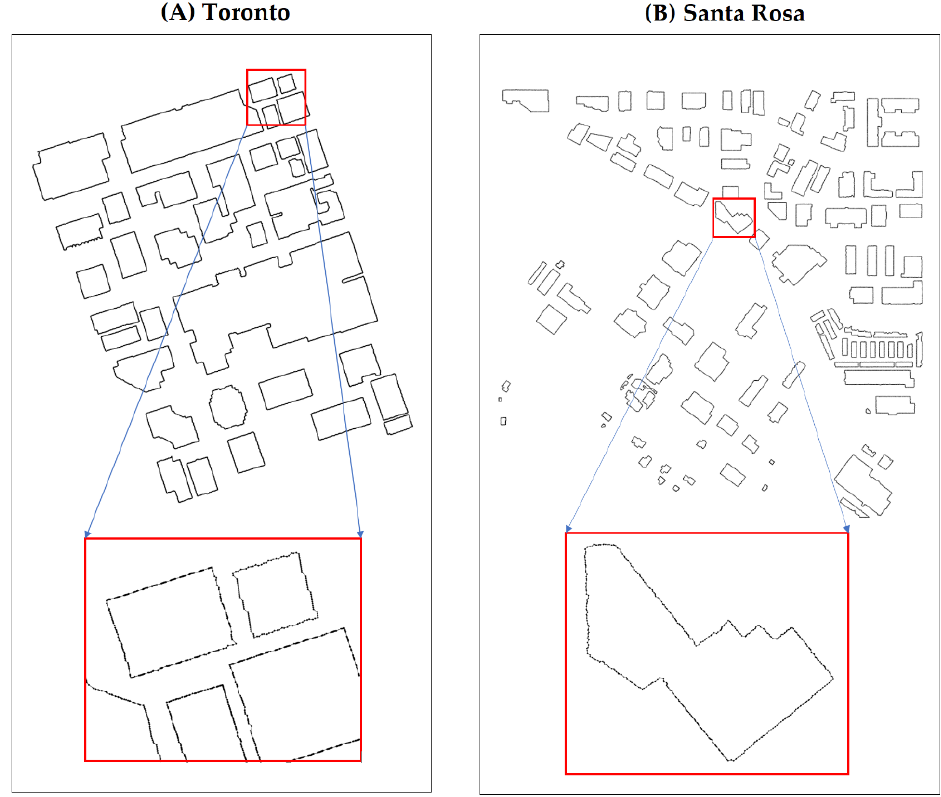
Figure 15. Initial Building Outline and magnified view. ( A )Toronto. ( B ) Santa Rosa.